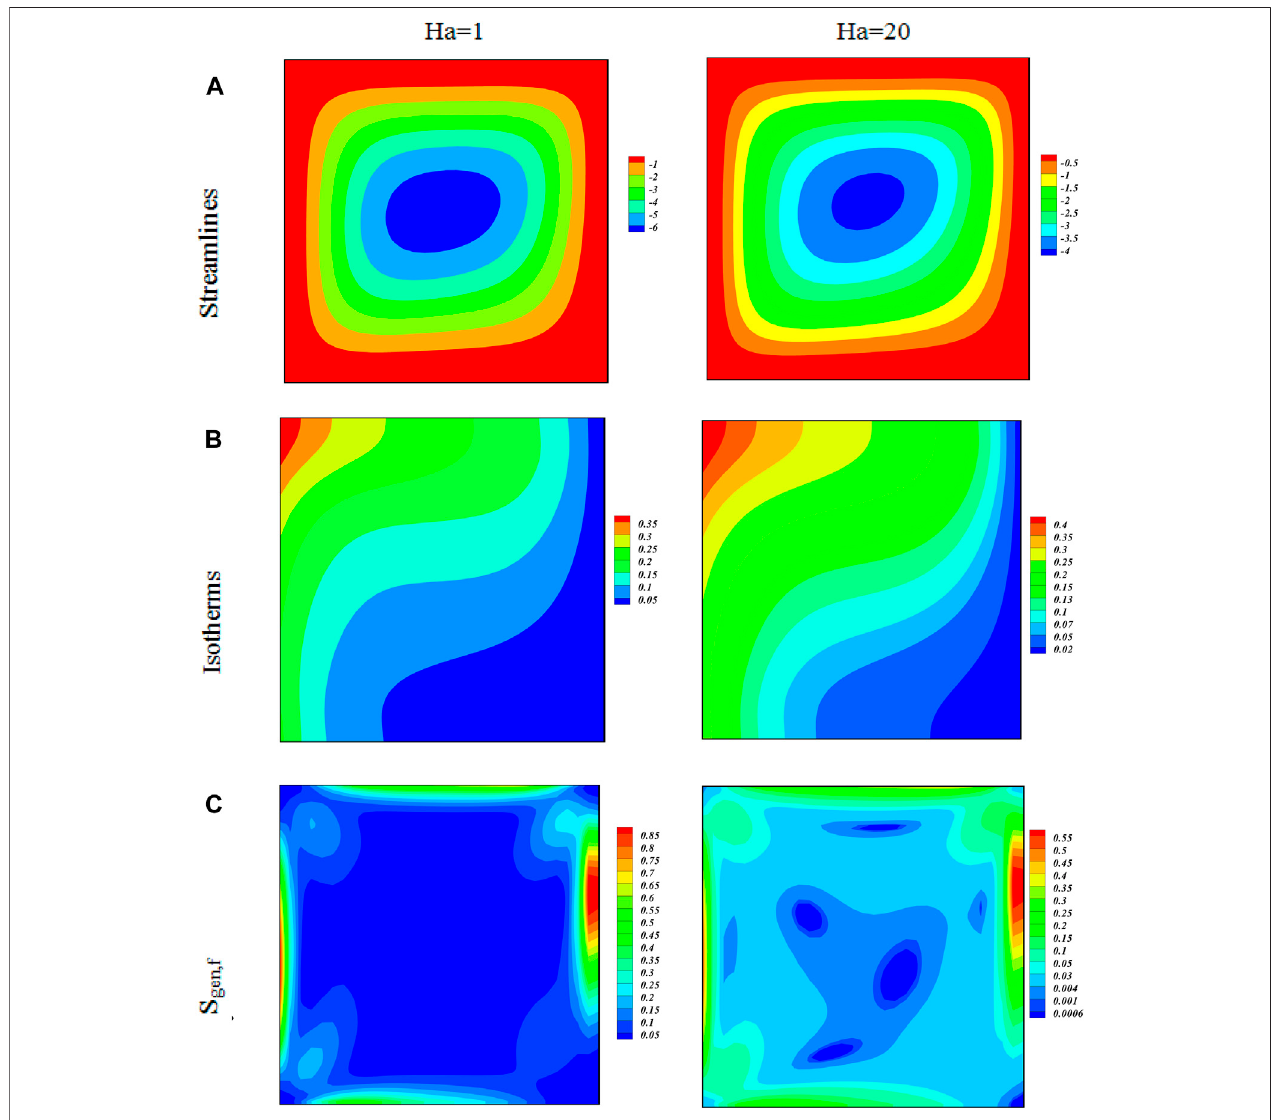
FIGURE 4 | Contour of streamlines, isotherms, irreversibility, and the Bejan Number changes at ϕ (cid:1) 0 . 04 , Ra (cid:1) 10 5 , Da (cid:1) 100 .